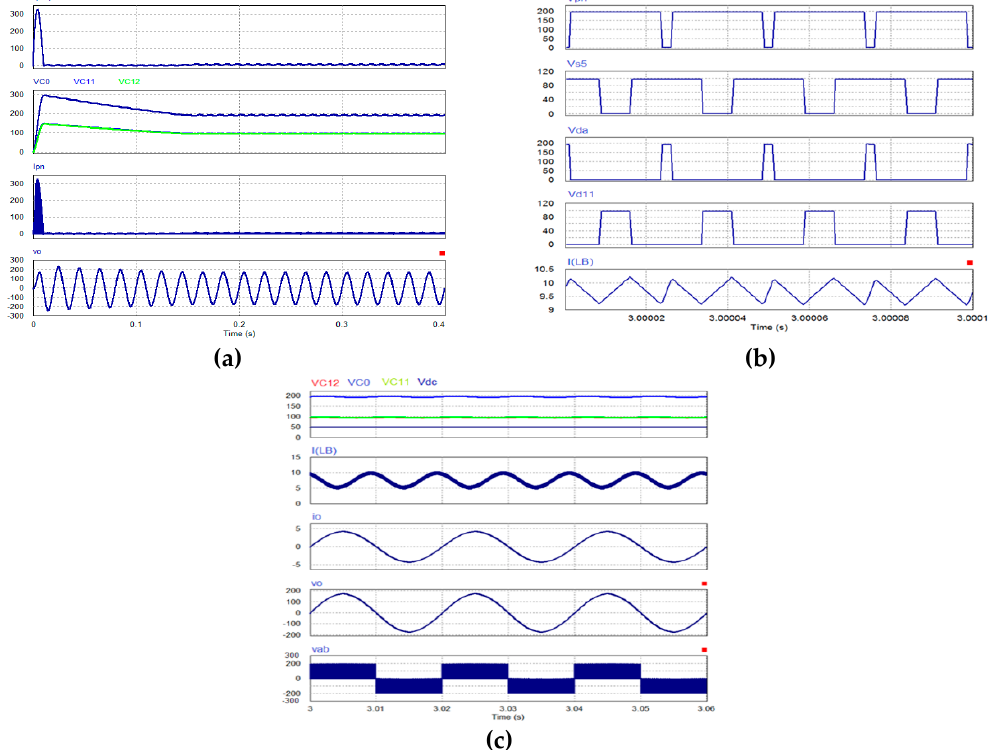
Figure 6. Simulation results for the proposed single-phase VMC-qSBI when V dc = 50 V. From top to bottom: ( a ) input current, capacitor voltages, dc-link current, and output voltage; ( b ) dc-link voltage, drain-source voltage of S 5 , diodes D a – D 11 voltage, and input current; and ( c ) input voltage and capacitors voltages, input current, output current, and output voltages before and after the L-C filter.